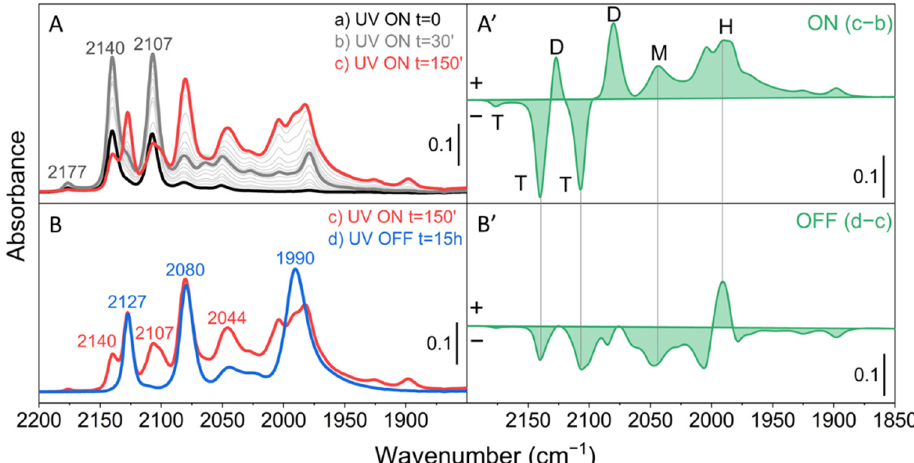
Figure 2. FT-IR spectra during photoreduction of Mo/SiO 2 in the presence of CO at 50 mbar. ( A ) Effect of photoreduction time up to 150 min of UV irradiation. ( B ) Effect of 15 h in dark conditions after photoreduction. The spectrum of the oxidized material in the presence of CO gas, before UV irradiation, has been subtracted from all spectra. ( A’ ) Difference spectrum (c − b) to underline the spectral evolution from 30 min to 150 min. ( B’ ) Difference spectrum (d − c) showing the effect of switching off the UV lamp. The letters T, D, M and H refer to the molybdenum species shown in Figure 1.